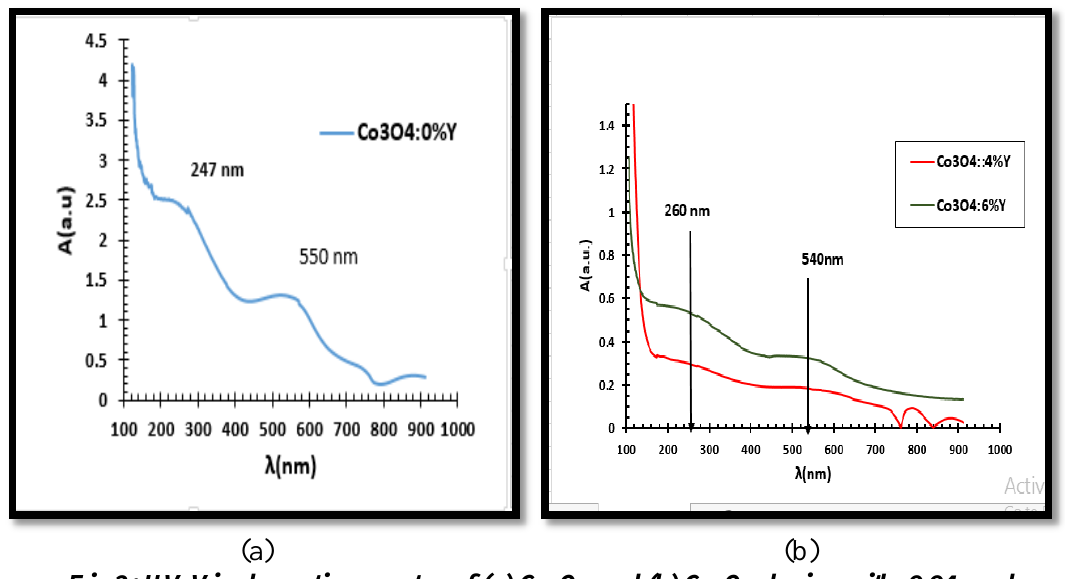
Fig.2: UV-Vis absorption spectra of (a) Co